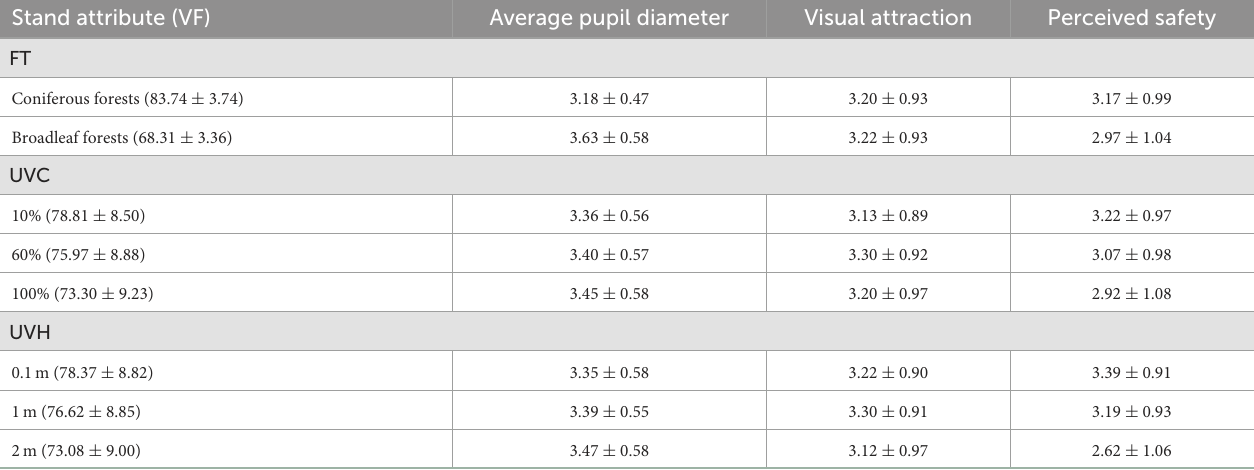
TABLE 2 Descriptive statistics for average pupil diameter, the scores of visual attraction and perceived safety. Stand attribute (VF)